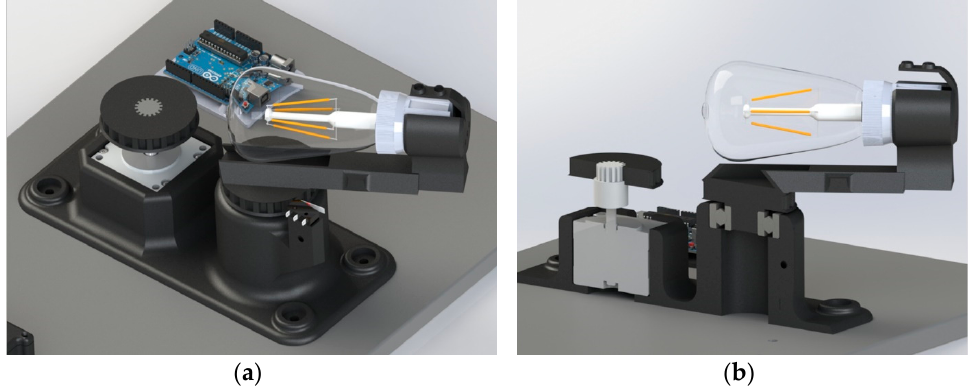
Figure 3. ( a ) 3D model of the light bulb rotation system; ( b ) Section view of the light bulb rotation system.